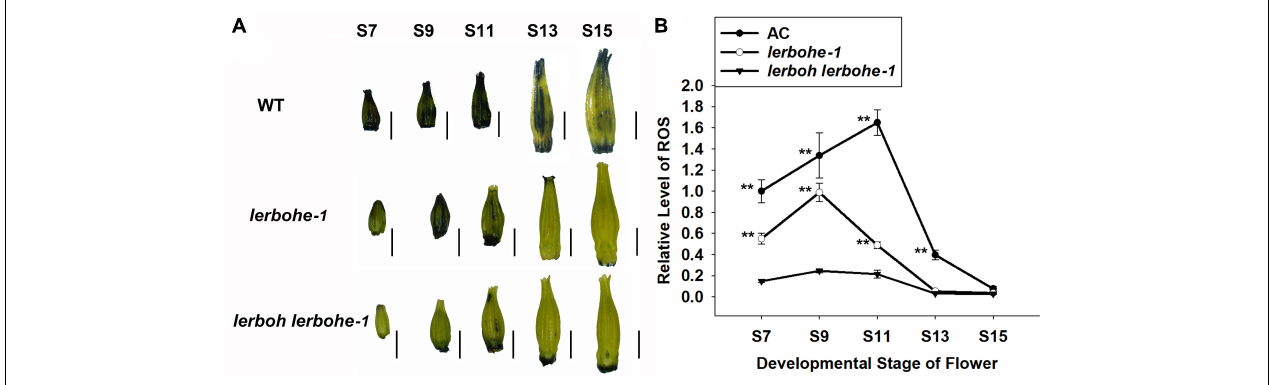
FIGURE 5 | lerbohe and lerboh lerbohe anthers displayed altered ROS accumulation. (A) NBT staining of anthers at different developmental stages. Scale bar: 1 mm. (B) Quantification of relative ROS levels calculated from mean pixel densities via Image J. The data was standard by the ROS content in stage7 (S7) of AC. The statistical difference between mutant and AC lines at the same stages was analyzed by Student’s t -test and ** meant P < 0.01.